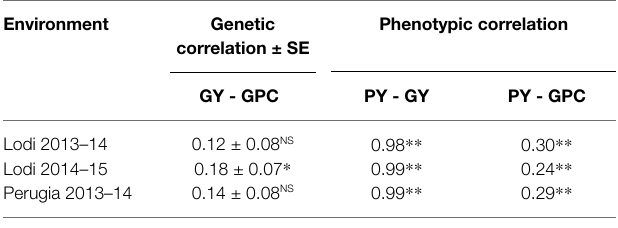
TABLE 6 | Predictive ability for three traits of four genomic selection models in the intra-population, inter-environment scenario obtained by using two environments for model training and one for validation.